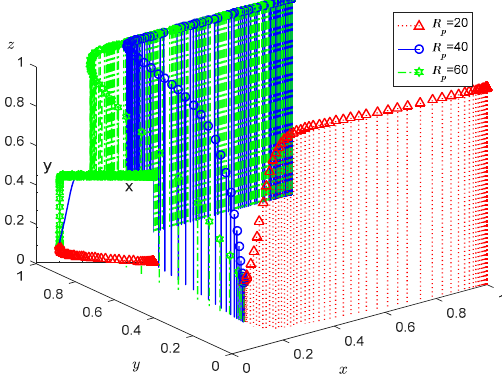
Figure 8. Simulation of evolutionary strategies of processors under different traceability benefits.